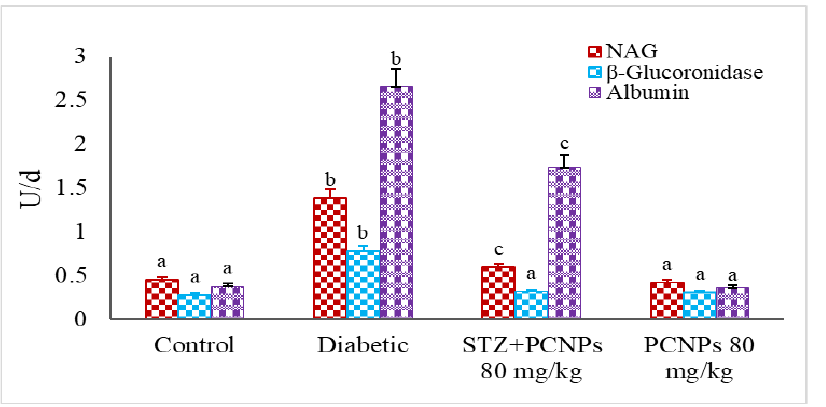
Figure 7. Activities of PCNPs on urinary NAG, β-Glucoronidase and microalbumin of control and experimental group. Values are means ± SD for six rats at p < 0.05 (DMRT). a PCNPs alone treated group compared with control group. b Diabetic group compared with control group. c Treatment group compared with diabetic